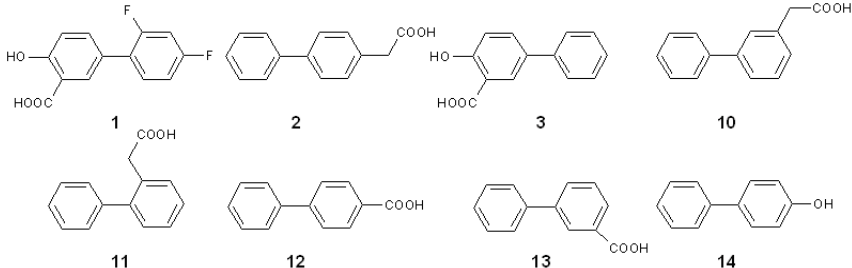
Figure 3. Prepared